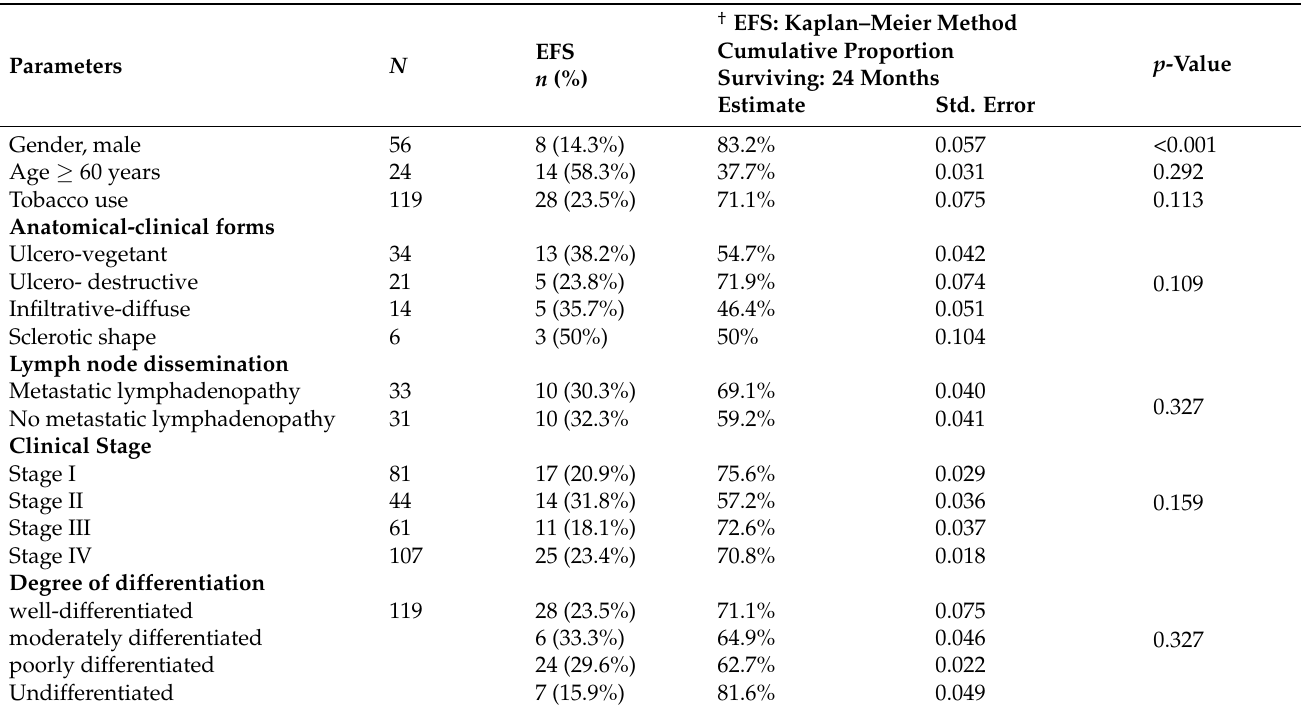
Table 5. Event-free survival (EFS) in carcinomas of the oral